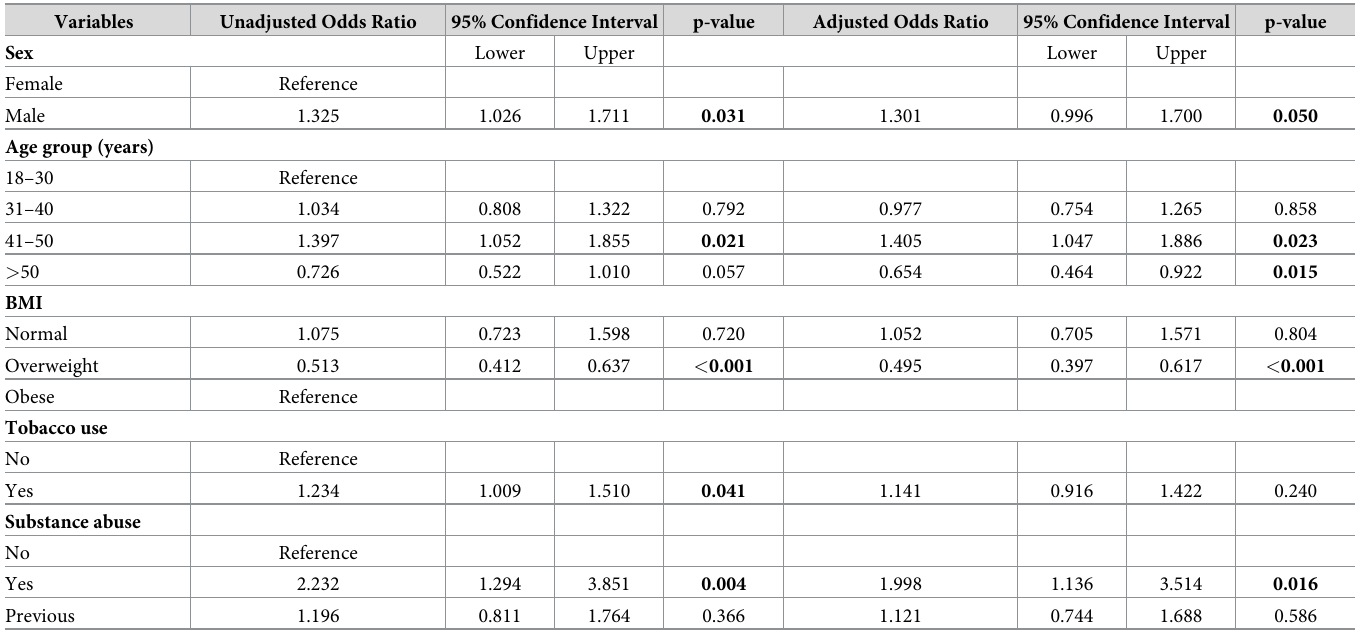
Table 2. Multiple logistic regression analysis: Predictors of MSD among